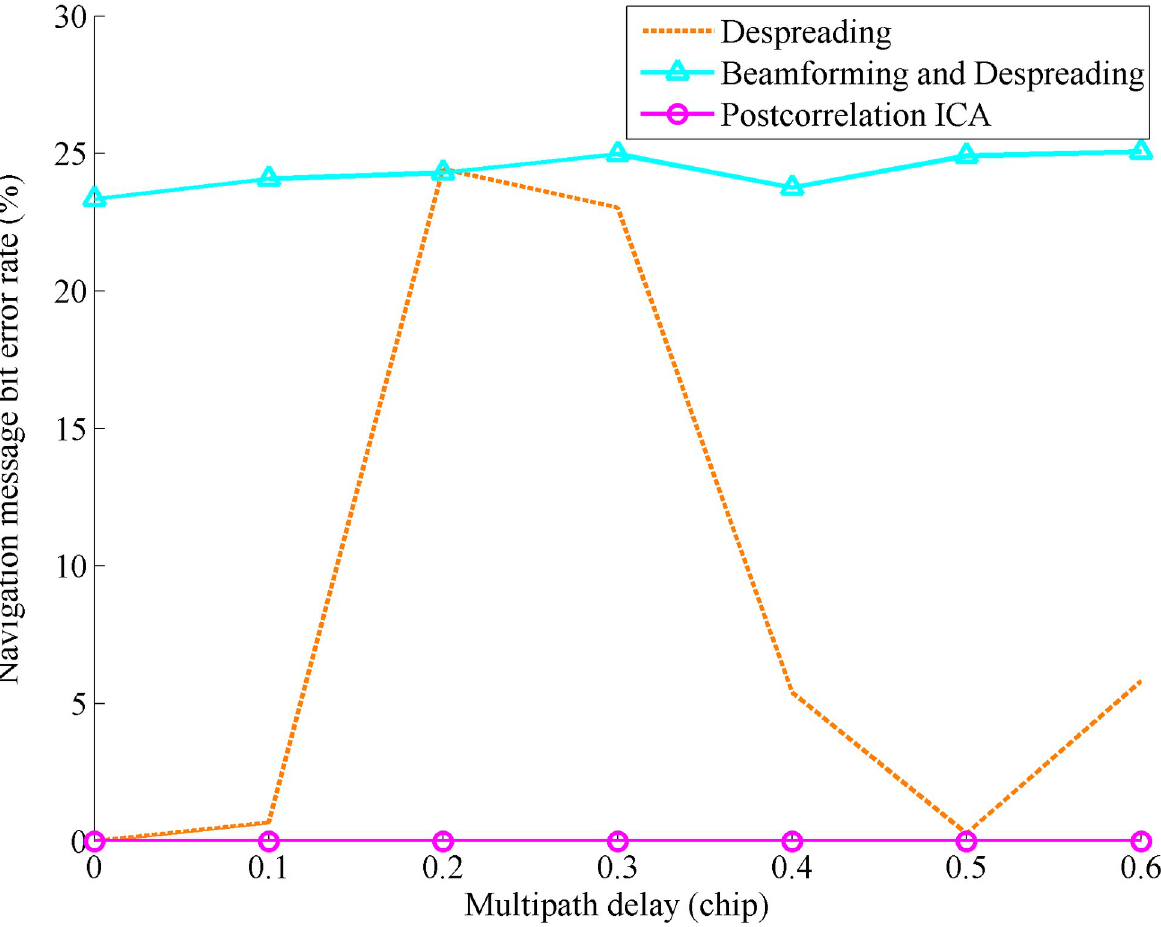
Fig 6. Bit error rate comparison of the navigation message with the multipath delay changing after despreading, beamforming and despreading, and postcorrelation ICA processing.